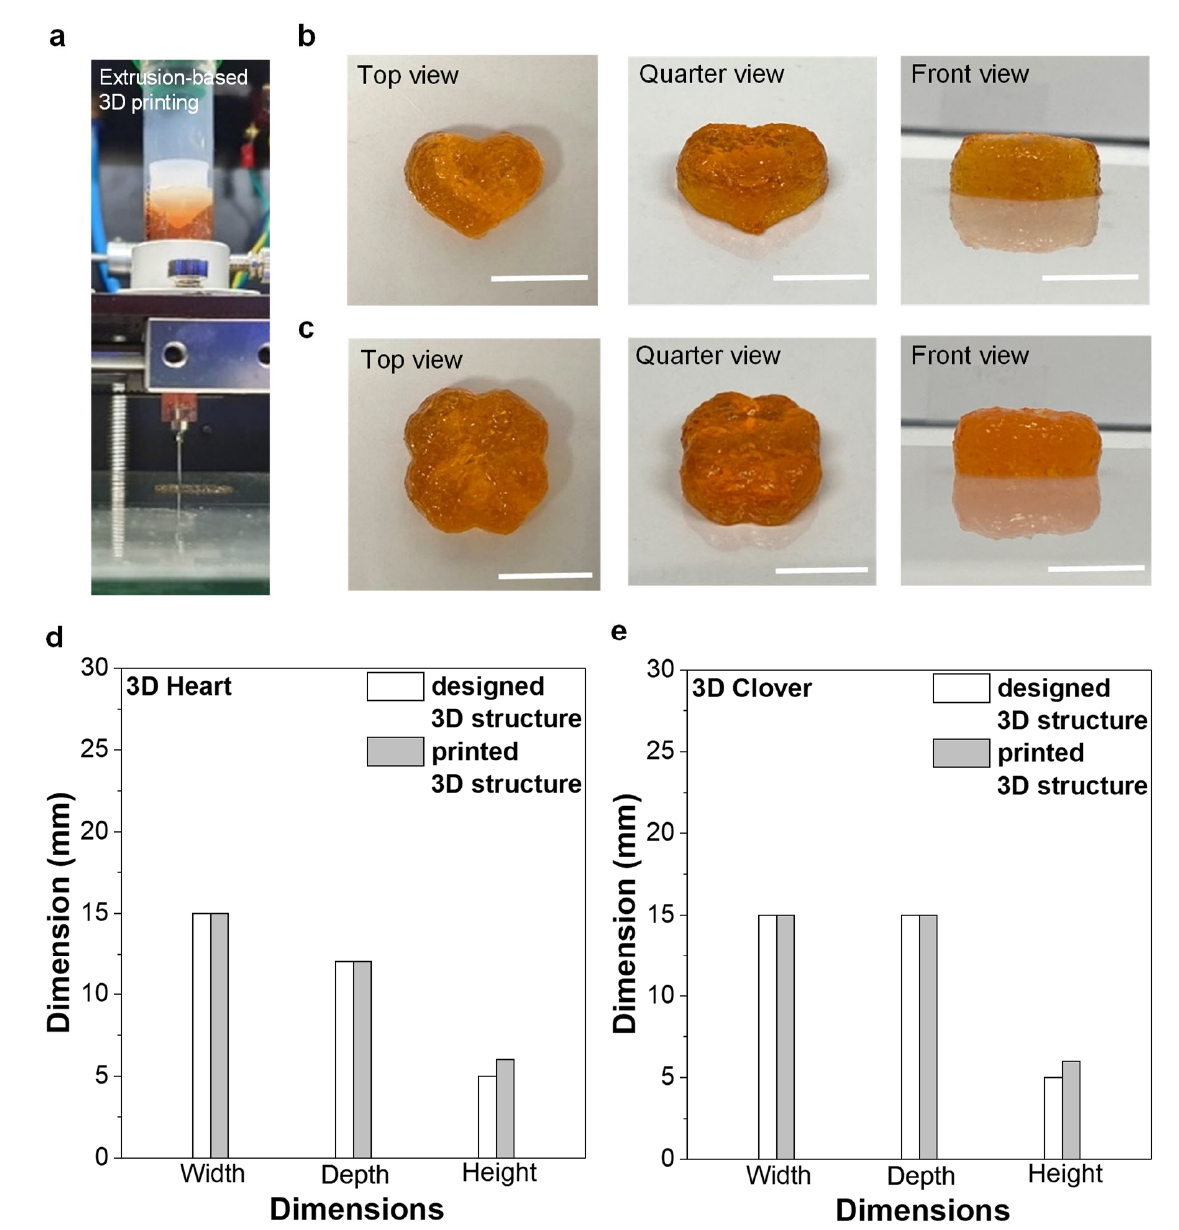
Figure 4. Three-dimensional printing of PAA-based self-healing hydrogel. ( a ) Photograph of extrusion-based 3D printer, ( b , c ) 3D-printed hydrogel structures in a heart shape ( b ) and a clover shape ( c ) (scale bar: 10 mm), ( d , e ) dimensional accuracy between the designed 3D structure and 3D-printed structure.